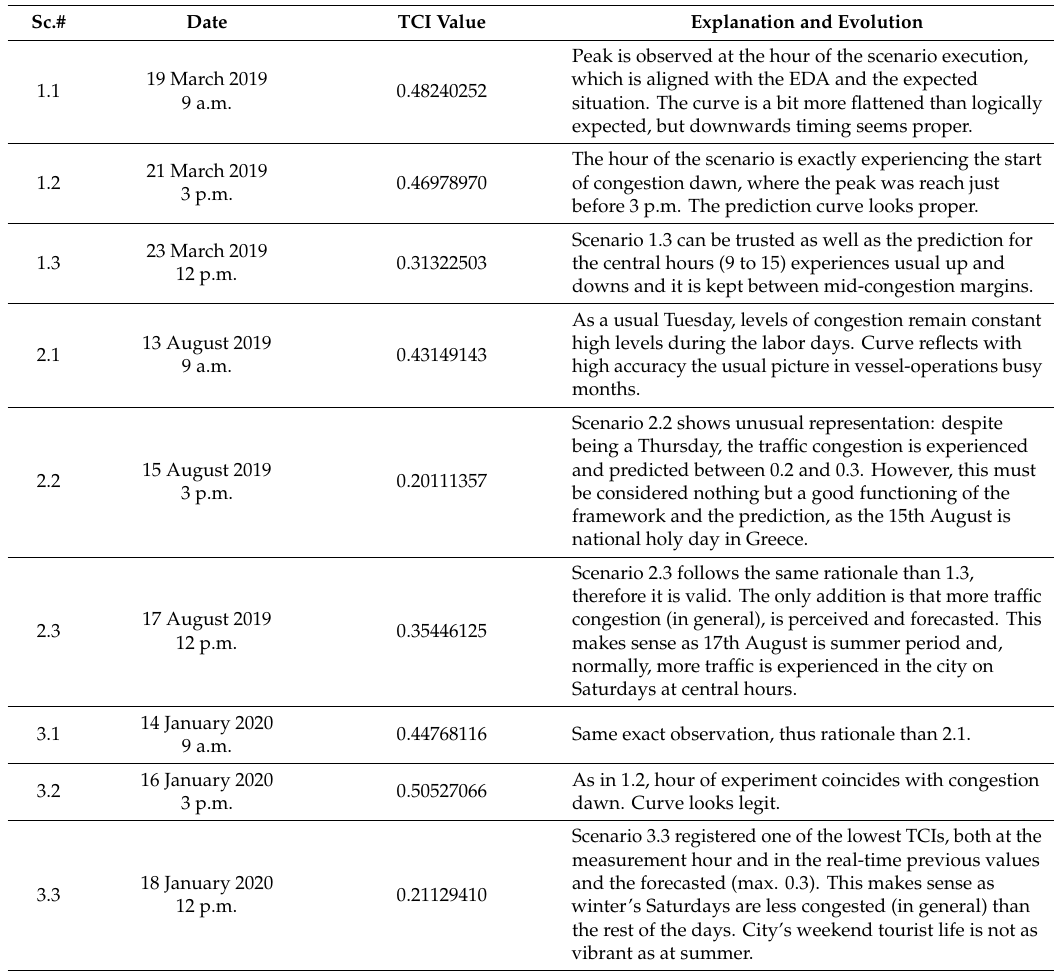
Table 8. Experiment results, reasoned per